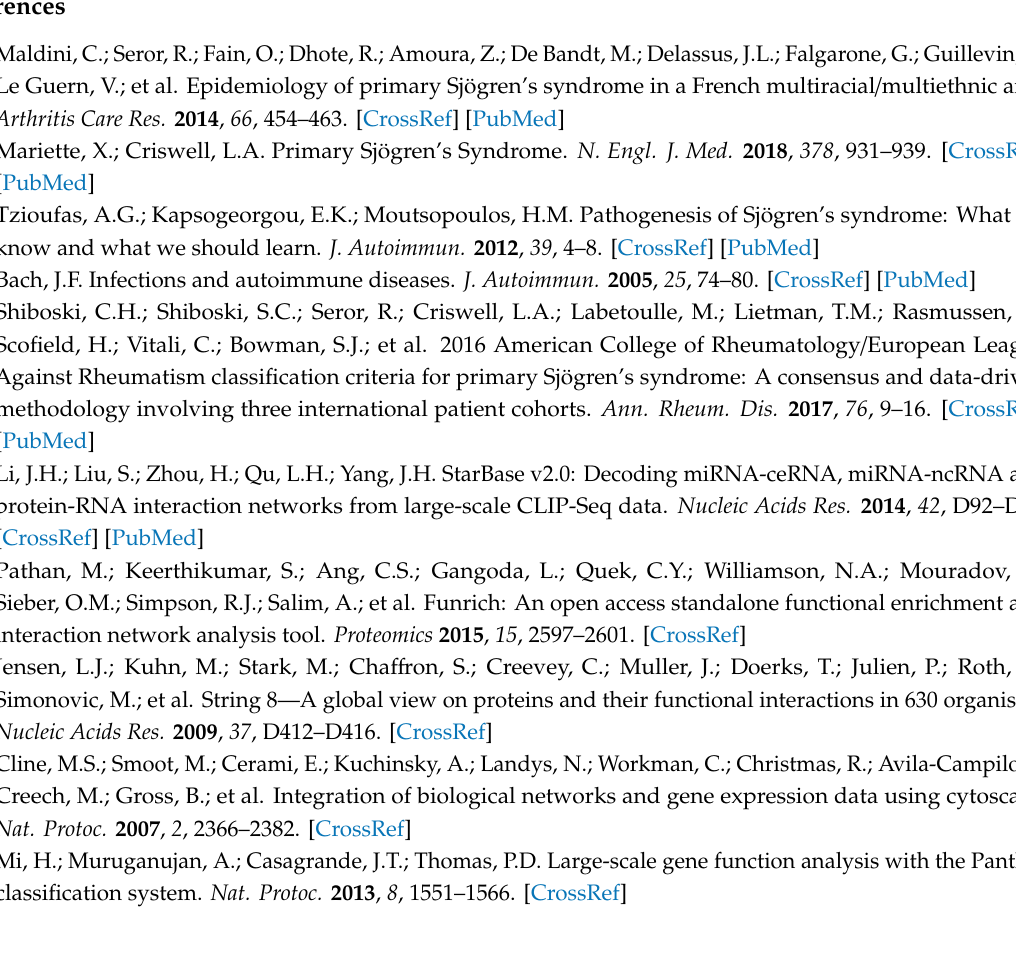
Table S1: Genes modulated in pSjS patients versus healthy subjects, Table S2: LncRNAs modulated in pSjS patients versus healthy subjects, Table S3: Genes modulated in pSjS patients that are targeted by the selected lncRNAs, Table S4: Genes modulated in pSjS patients that are included in the 7 Modules, Table S5: Module-associated modulated genes that are targeted by the selected long non-coding RNAs, Table S6: MiRNAs targets of the selected lncRNAs that regulated genes included in the seven modules, Table S7: Signaling pathways enriched in modulated genes targeted by the selected lncRNAs, Table S8: Signaling pathways enriched in modulated genes included in modules, Figure S1: Validation by RT-PCR. (A) Expression of the three selected lncRNAs in pSjS patients and healthy controls analysed in the study. (B) Expression of selected miRNAs targeted by the three selected lncRNAs in pSjS patients and healthy controls analysed in the study. (C) Expression of selected genes modulated in pSjS samples and healthy controls analysed in the study. Bars indicate SD; p -values versus healthy controls <